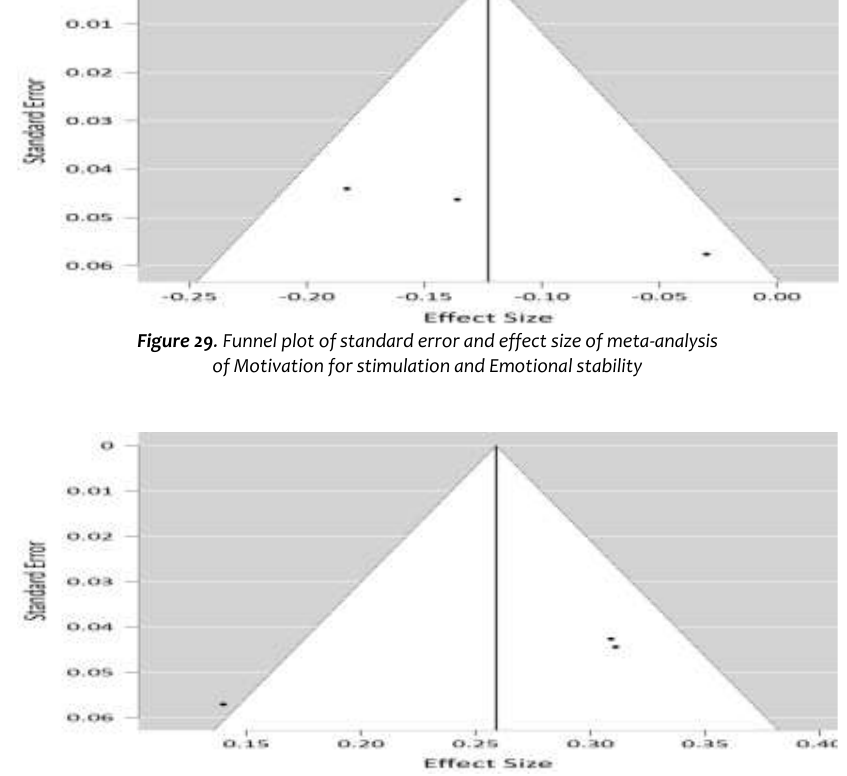
Figure 30 . Funnel plot of standard error and effect size of meta-analysis of Motivation for knowledge and L2 test